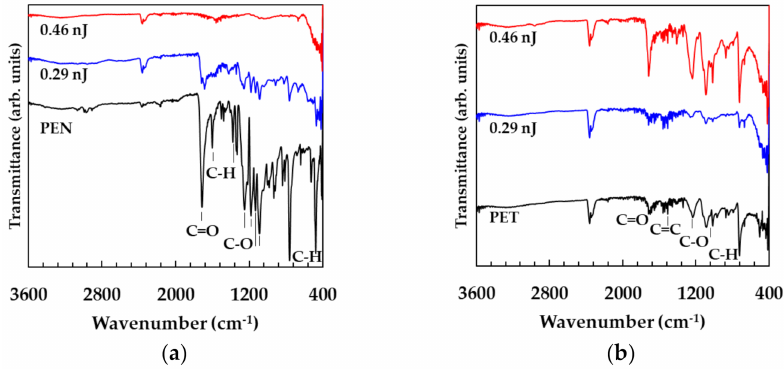
Figure 9. FT-IR spectra of the patterns on ( a ) PEN and ( b ) PET